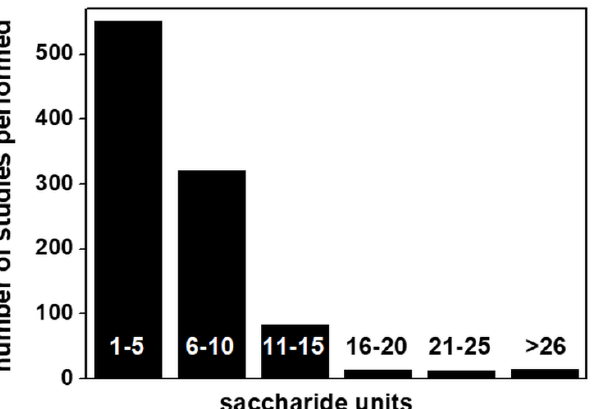
Figure 10. Distribution of computational studies with respect to GAG length. For further details on the bibliographic research strategy, see Appendix A.